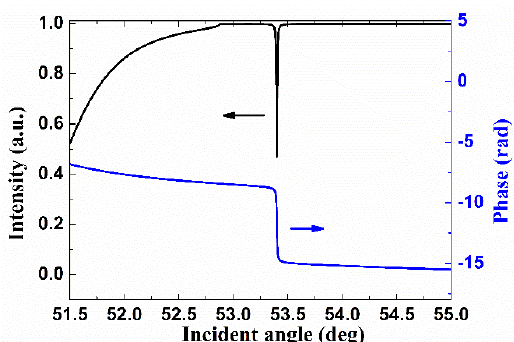
Figure 3. Simulated angular reflectance and phase response when the external medium is water for P-polarized input.